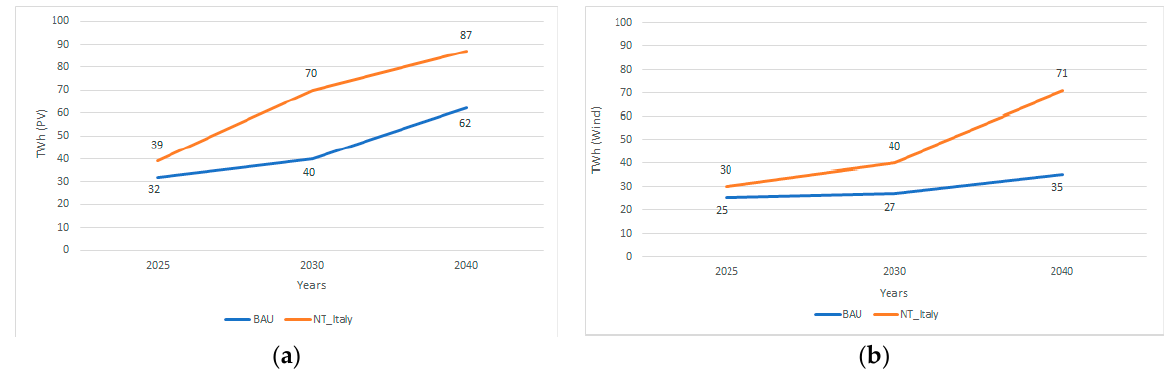
Figure 10. Italian generation forecast for the time horizon 2025, 2030, 2040: ( a ) PV; ( b ) wind.